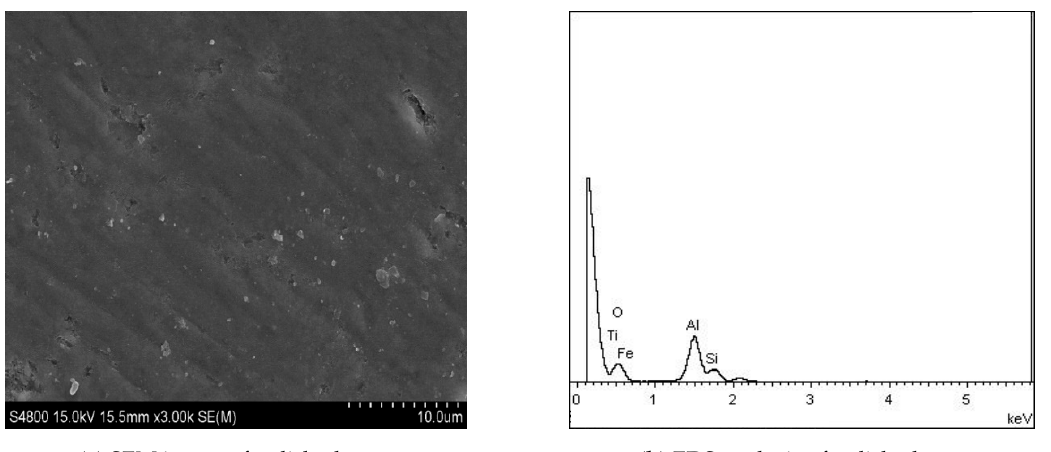
( a ) SEM image of polished area. Figure 11. SEM ‒ EDS images of polished area. Figure 11. SEM-EDS images of polished